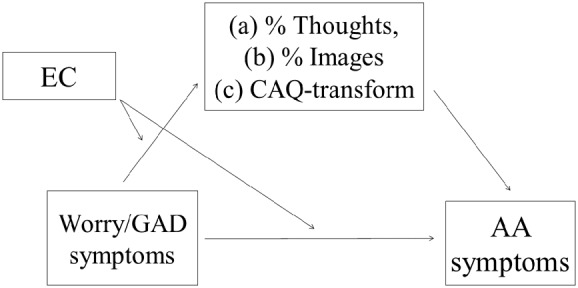
Conceptual model for tests of moderated mediation.